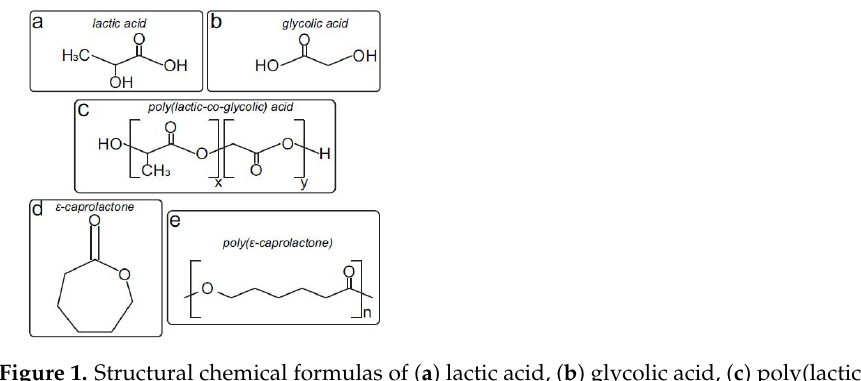
Figure 1. Structural chemical formulas of ( a ) lactic acid, ( b ) glycolic acid, ( c ) poly(lactic-co-glycolic) acid, ( d ) ε -caprolactone and ( e ) poly( ε -caprolactone). PLGA and PCL degrades via chain scissions of ester bond linkages in the polymer backbone ( c , e ) by hydrolytic attack of water